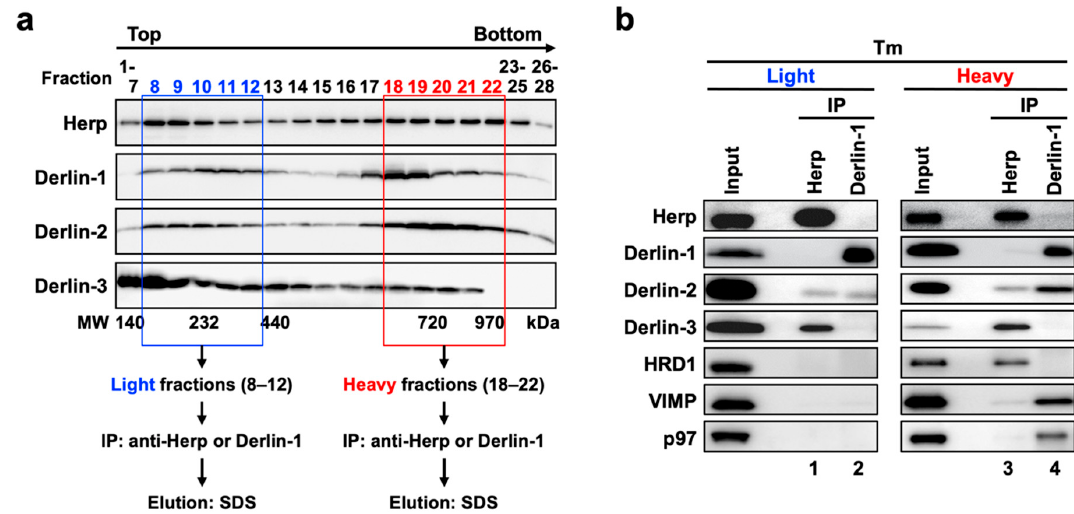
Figure 6. Physical interactions among ERAD factors in the light and heavy fractions obtained from sucrose density gradient centrifugation. ( a ) Experimental workflow. Liver microsomes prepared from Tm-treated WT mice were subjected to sucrose density gradient centrifugation, and the light (8–12) and heavy (18–22) fractions were used for the coimmunoprecipitation experiments. ( b ) Coimmunoprecipitation analyses on the light and heavy fractions. The eluates were analyzed by Western blotting using antibodies indicated on the left side. IP, immunoprecipitation.